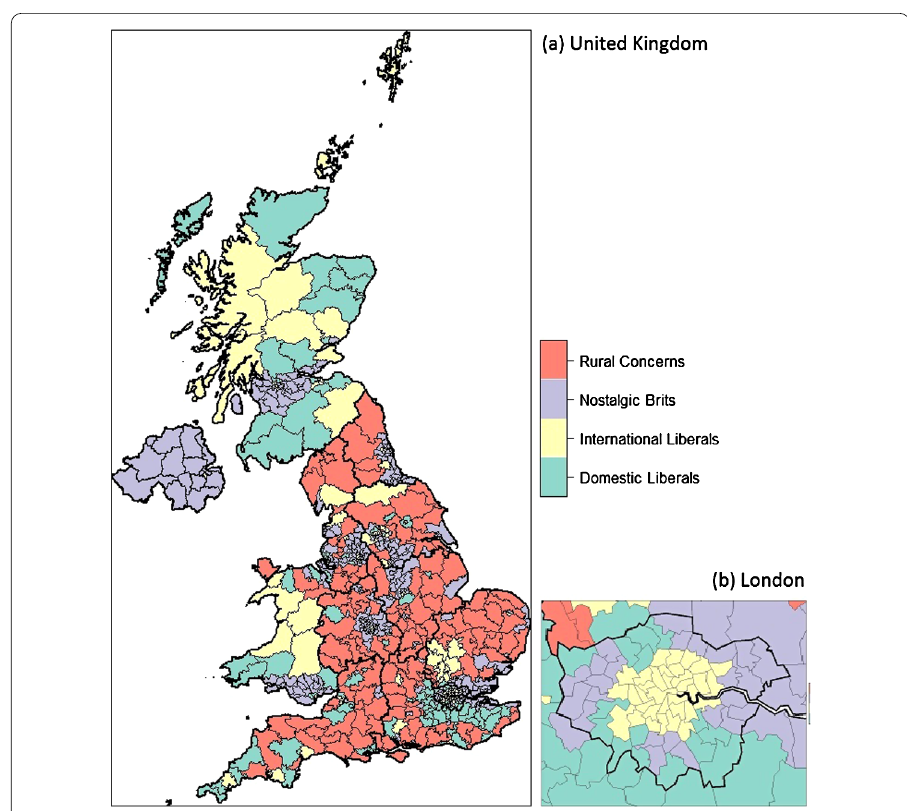
Figure 7 Geographical location of classes in (a) UK; and (b)